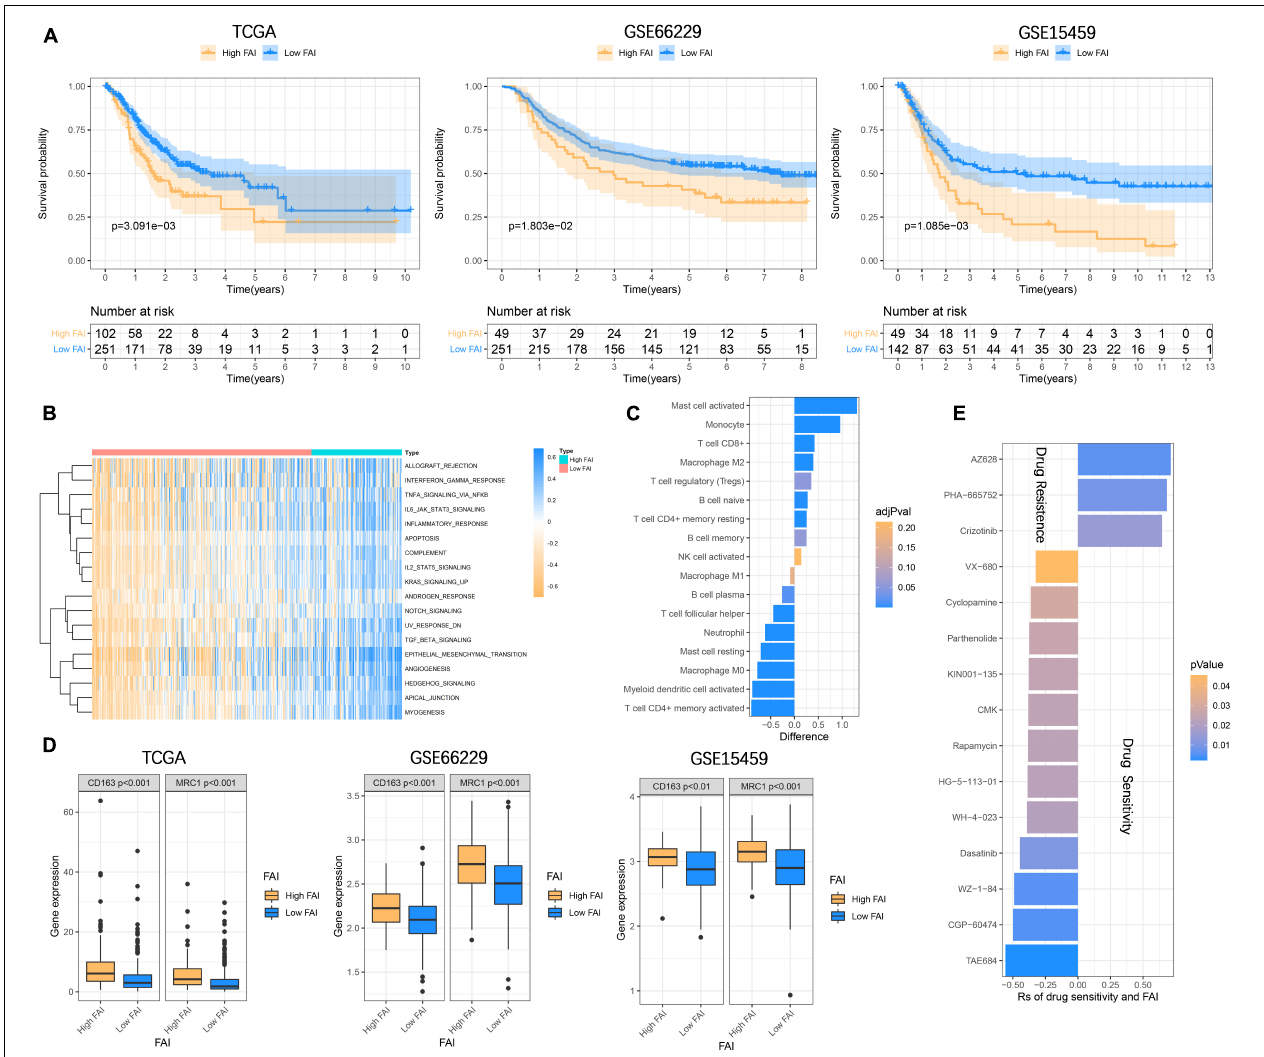
FIGURE 5 | Focal adhesion index assesses the prognosis and immune cell infiltration (A) FAI is closely related to the overall survival of GC patients, and the survival time of High FAI patients is significantly lower than that of Low FAI. (B) The heatmap shows that the immune signaling pathway is significantly enriched in the High FAI group. (C) The immune cells infiltrated in the high and low FAI groups. (D) M2 macrophage markers expression. (E) Major signaling pathway inhibitor explorations in the GDSC